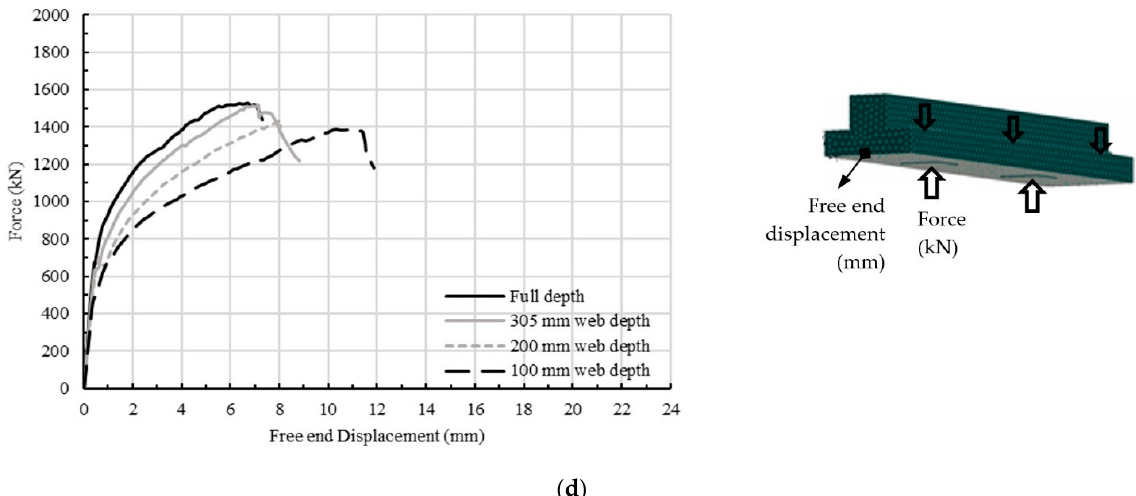
Figure 11. Force-displacement response of inverted T-beams with different web heights/depths: ( a ) Non-skewed (0 ⁰ );